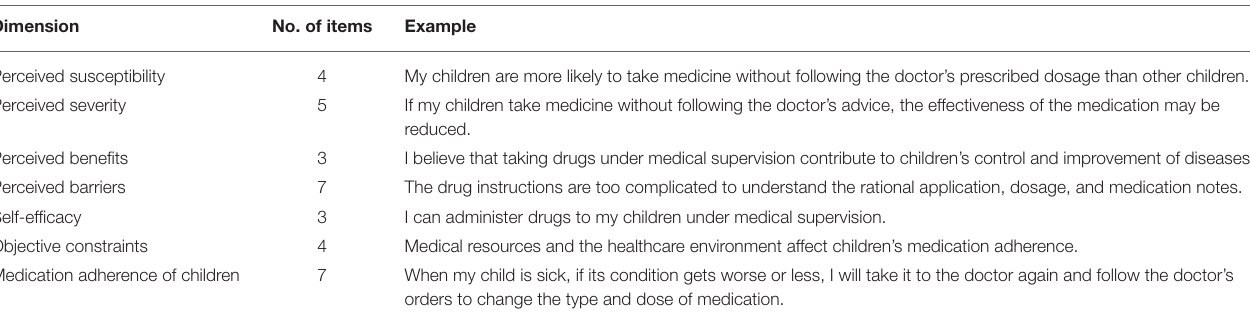
TABLE 1 | Questionnaire structure for health belief section.